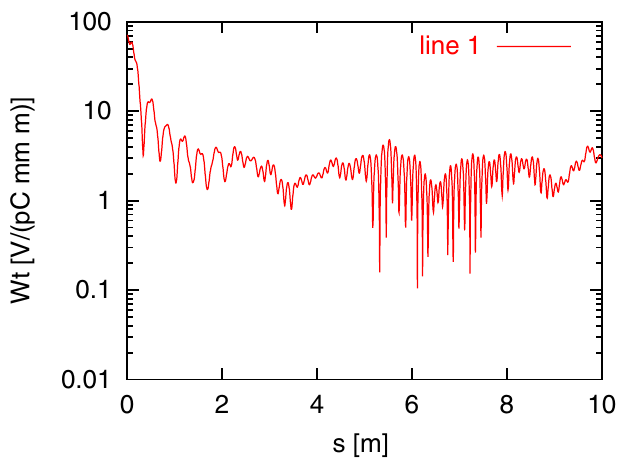
FIG. 15. (Color) Transverse wake function of X -band